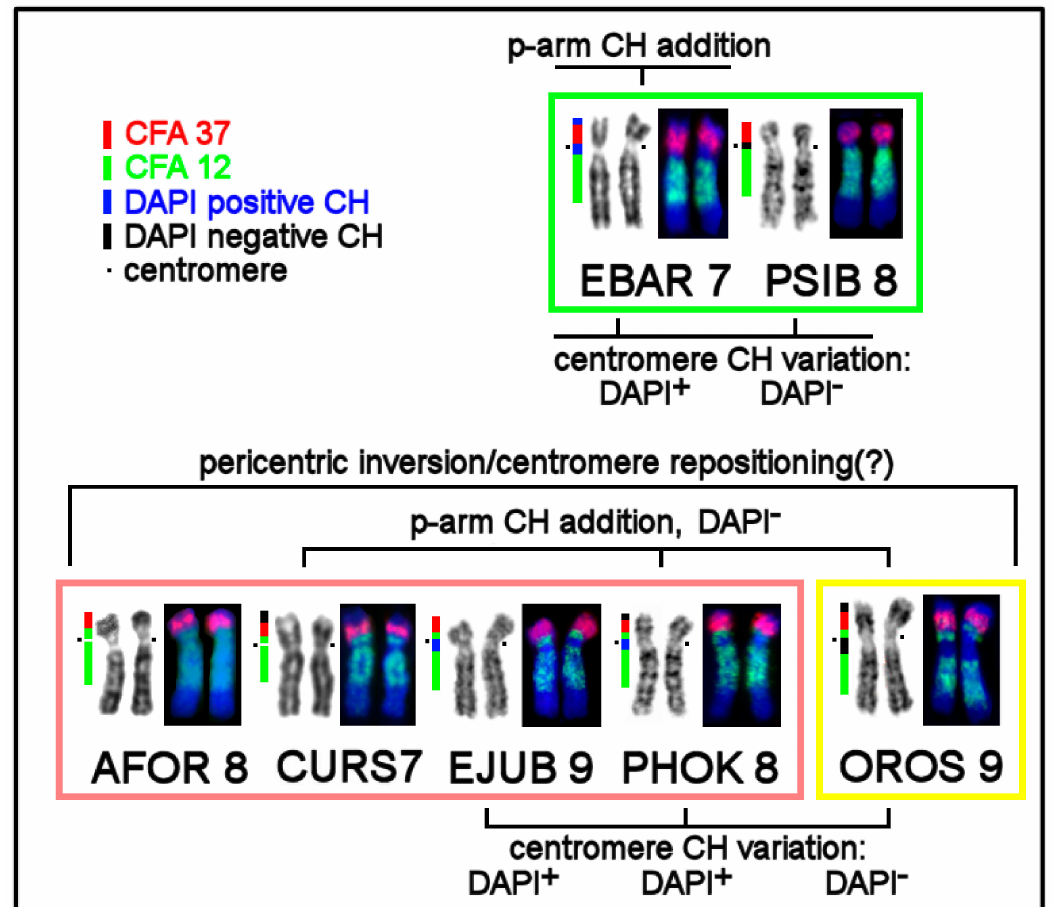
Figure 6. Pericentric inversion or centromere repositioning (?) in Odobenidae and Otariidae as revealed by dog painting probes CFA 37 / 12 (ACK 6). Pinniped families are designated by color boxes: green, Phocidae; pink, Otariidae; and yellow,